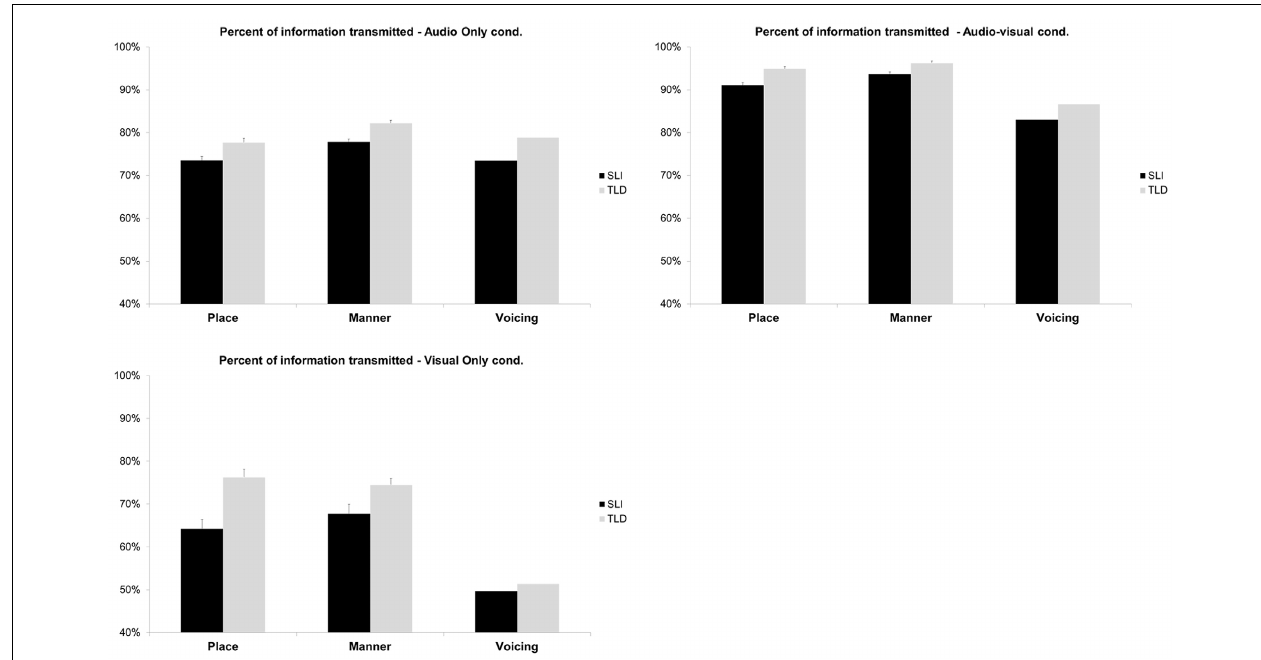
FIGURE 4 | Percent of information transmitted for place, manner, and voicing, as a function of group (SLI vs. TLD) and modality (auditory, audiovisual, and visual).